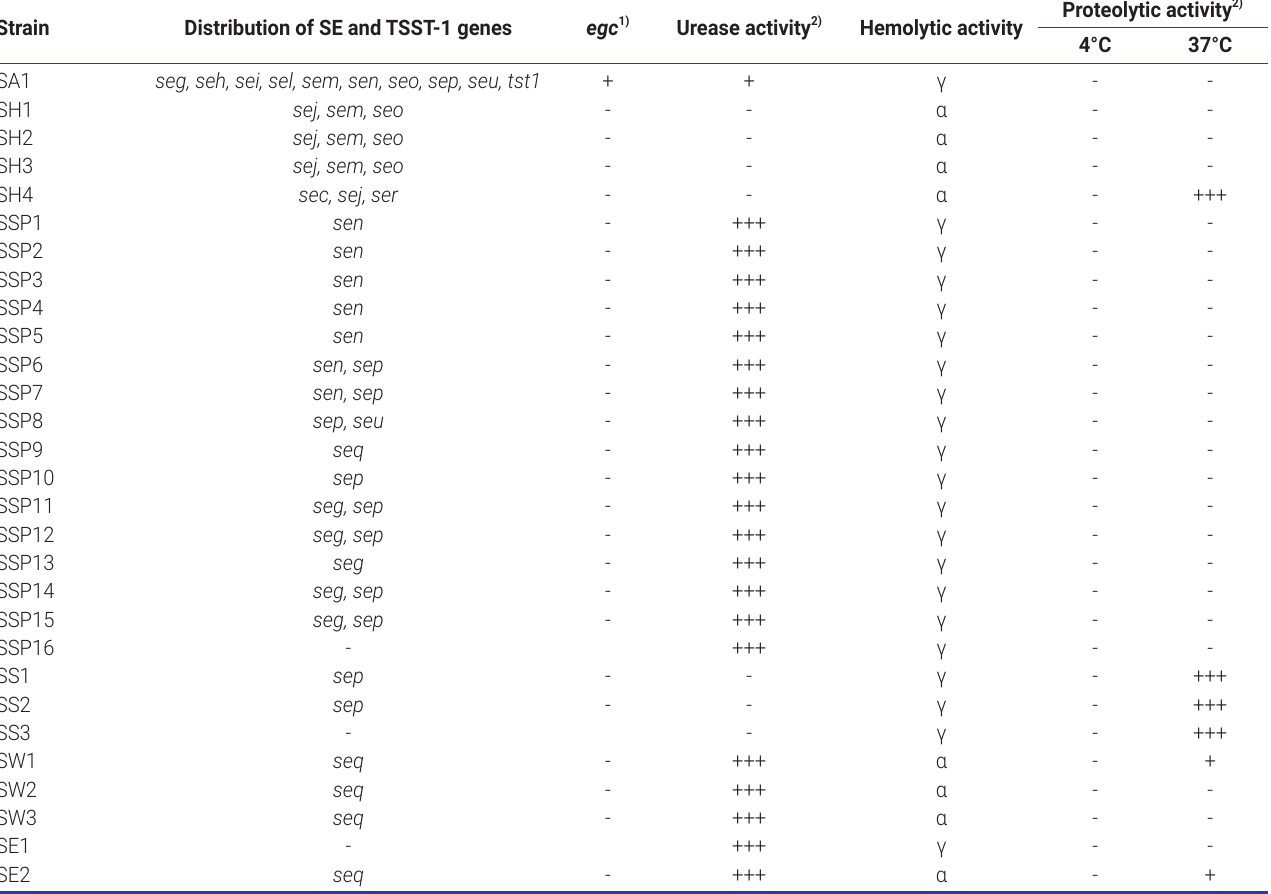
Table 4. Carriage of SE and TSST-1 genes and exoenzyme activities in CoPS and CoNS isolated from pork meat samples Strain